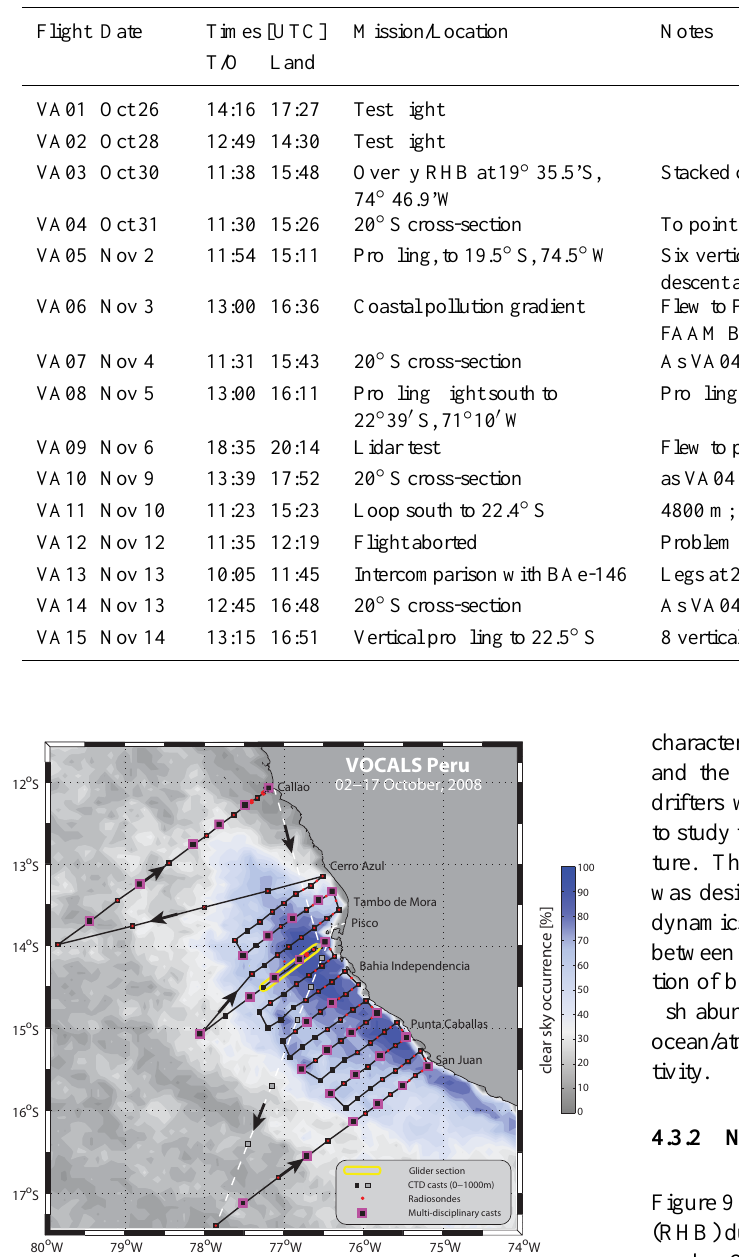
Table 9. Details of Do-228 aircraft missions conducted in the VOCALS Regional Experiment.